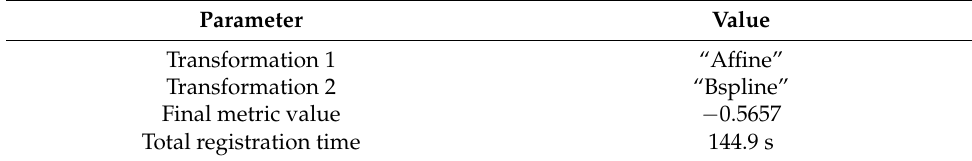
Table 9. Result of one slice registration using